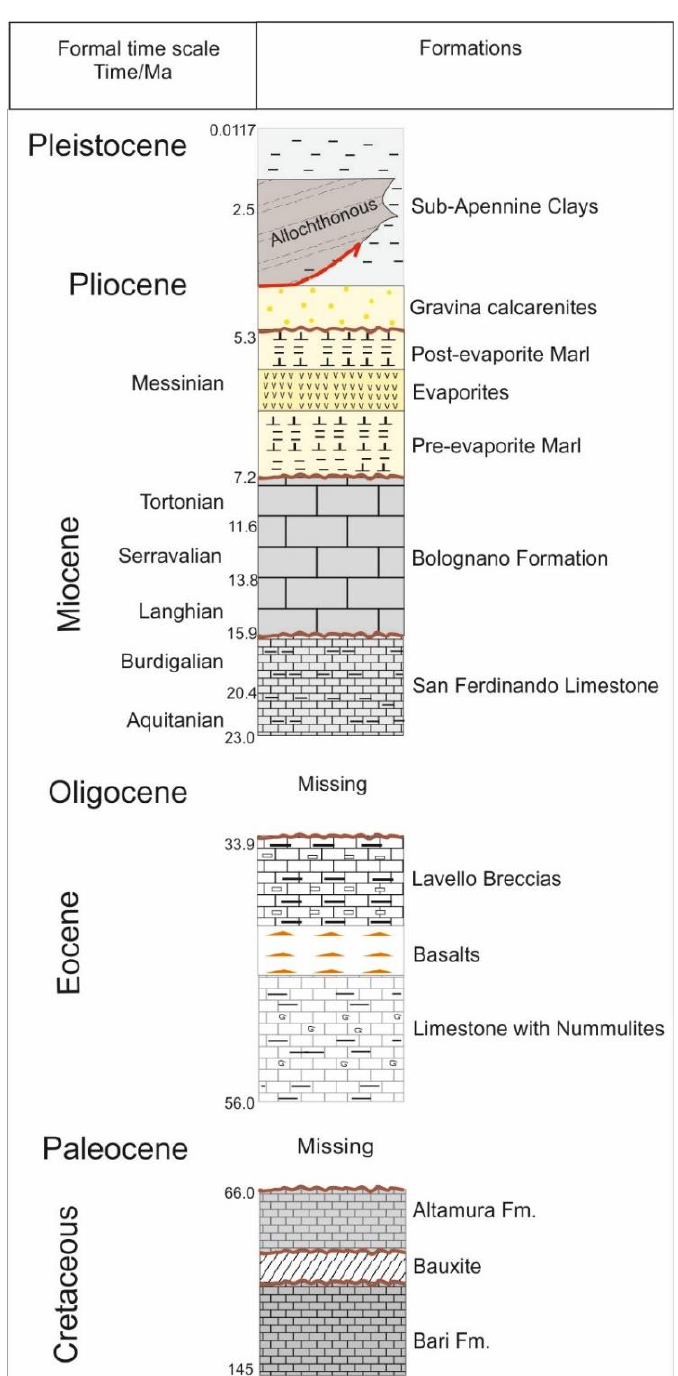
Figure 2. General stratigraphic column (not to scale) recognized in exploration wells showing the succession of the Apulian Platform and the foredeep units